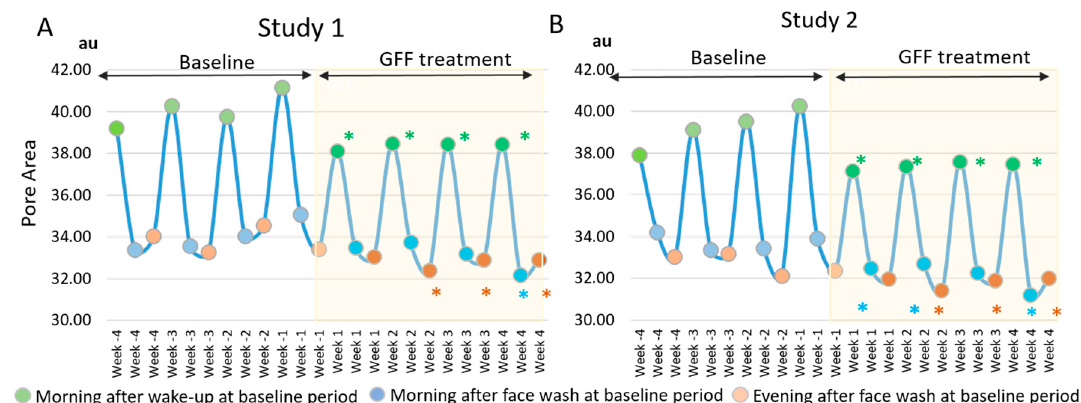
measurement period, we plotted weekly average values of the pore area (Figure 5).